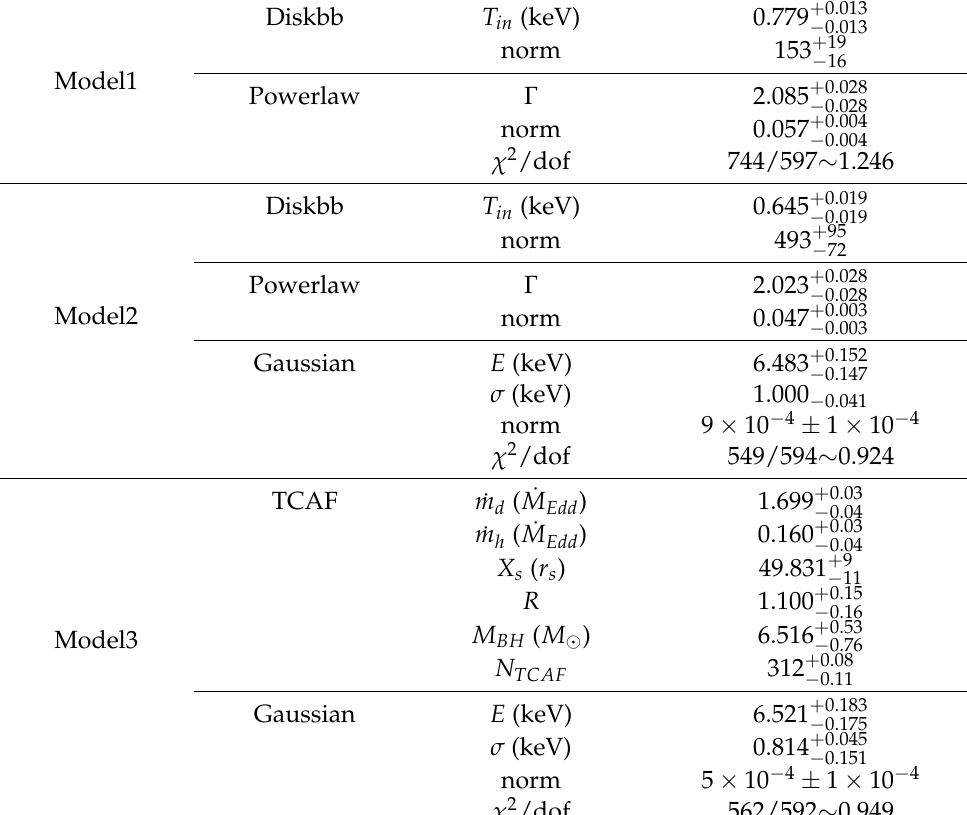
Table 1. Spectral Analysis Results obtained from NuSTAR Observation.